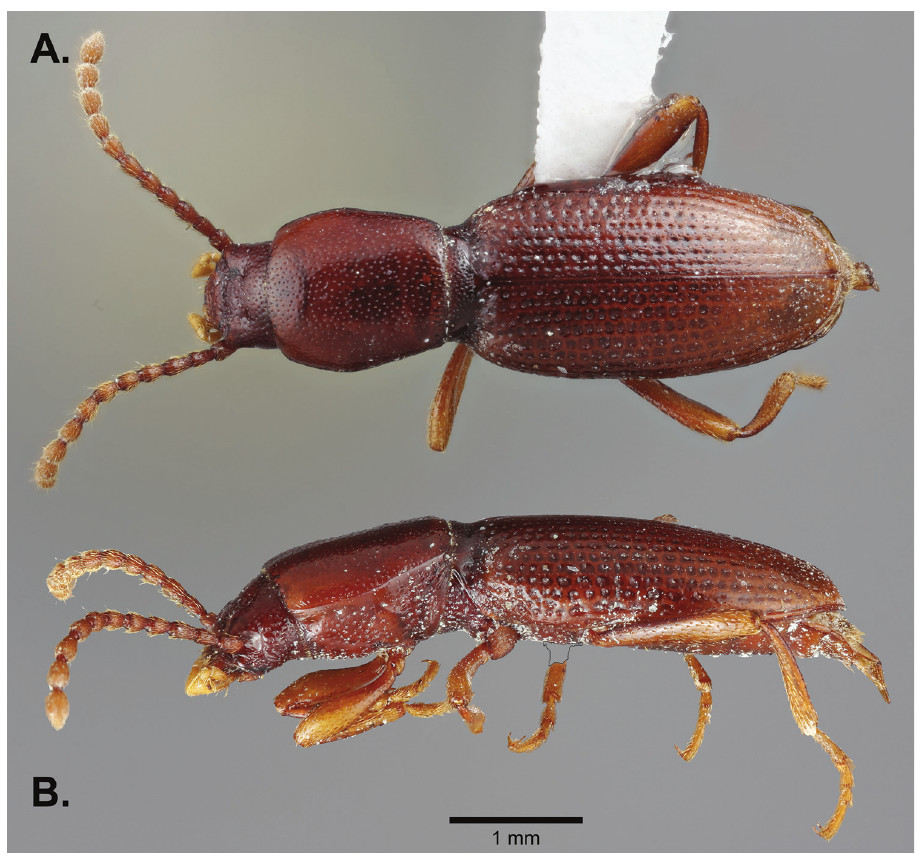
Figure 2. Habitus of Eschatoporis styx sp. n.: A Dorsal B Lateral. Body elongate, semi-cylindrical,